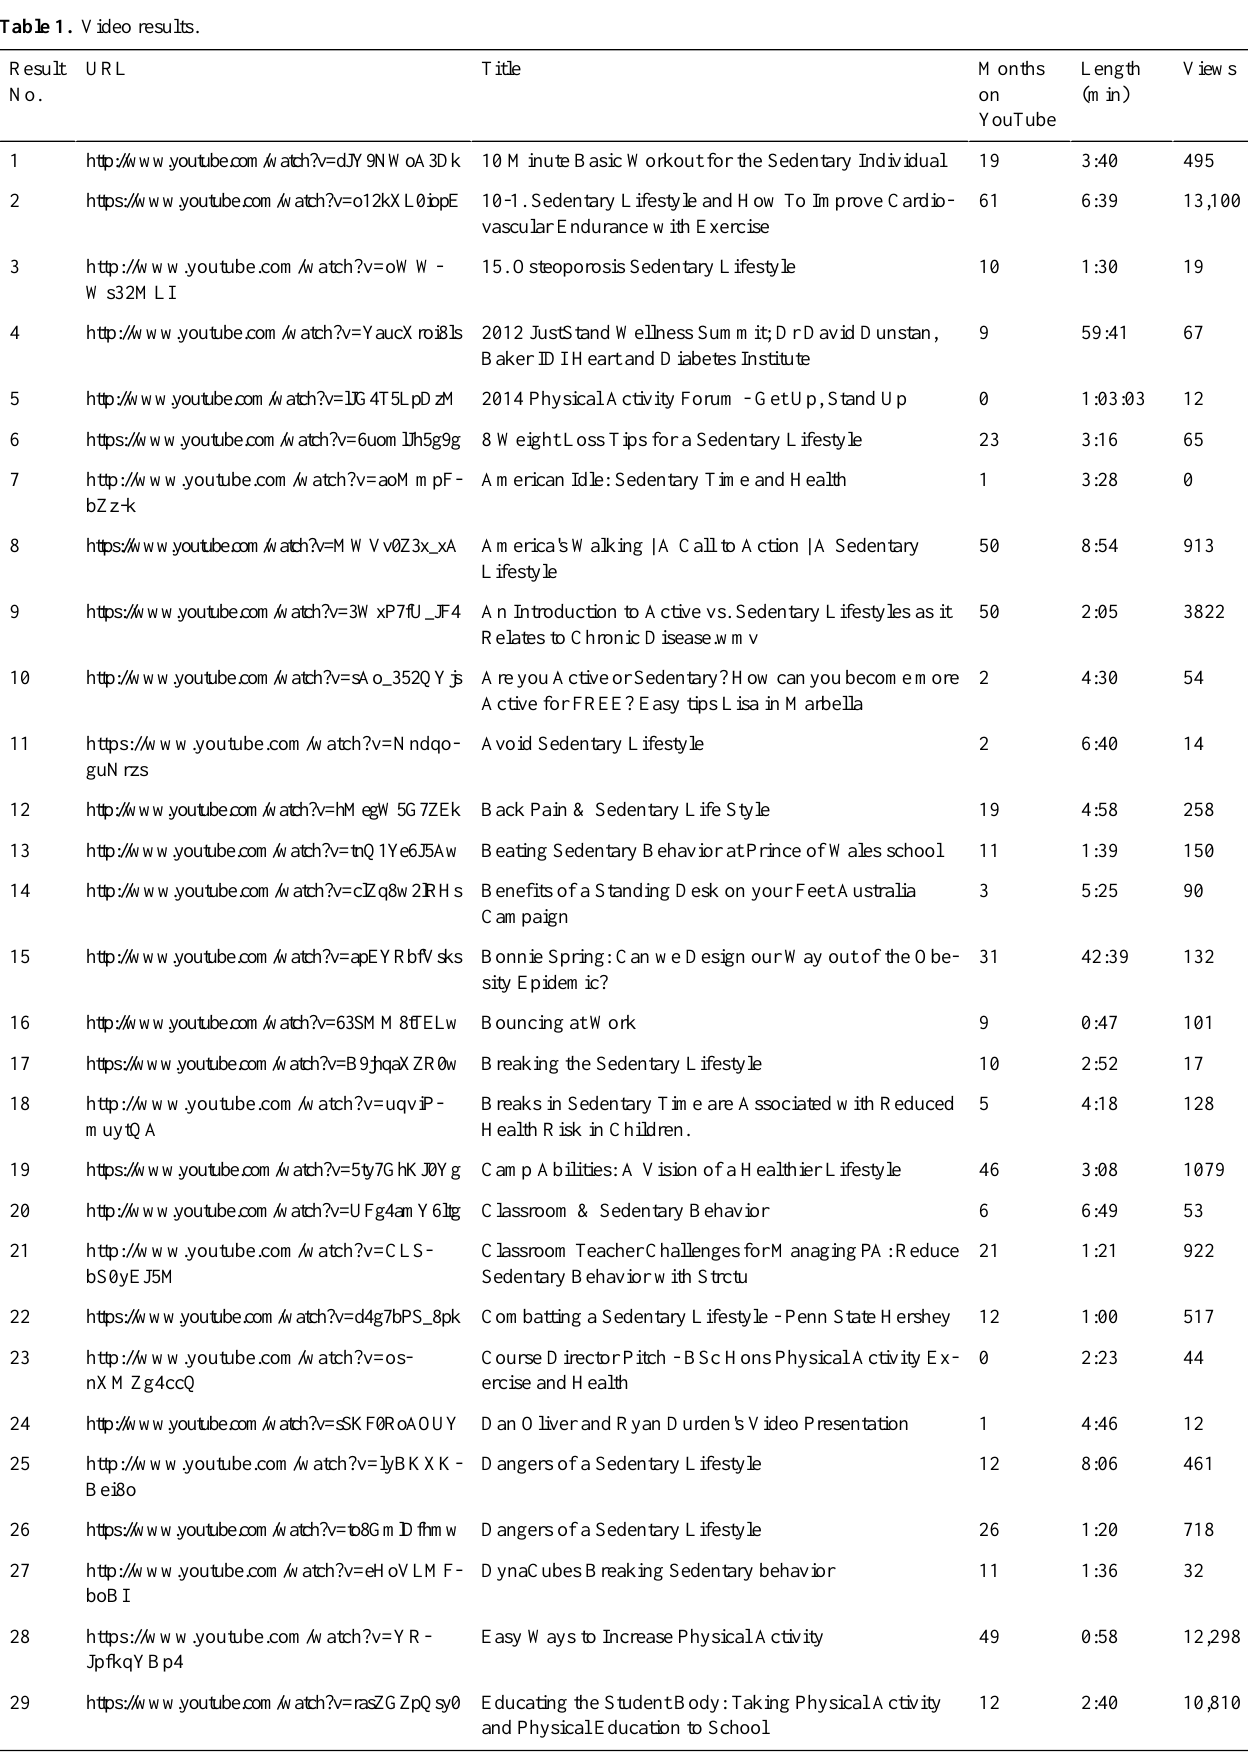
Table 1. Video results. YouTubeTitleURLResult